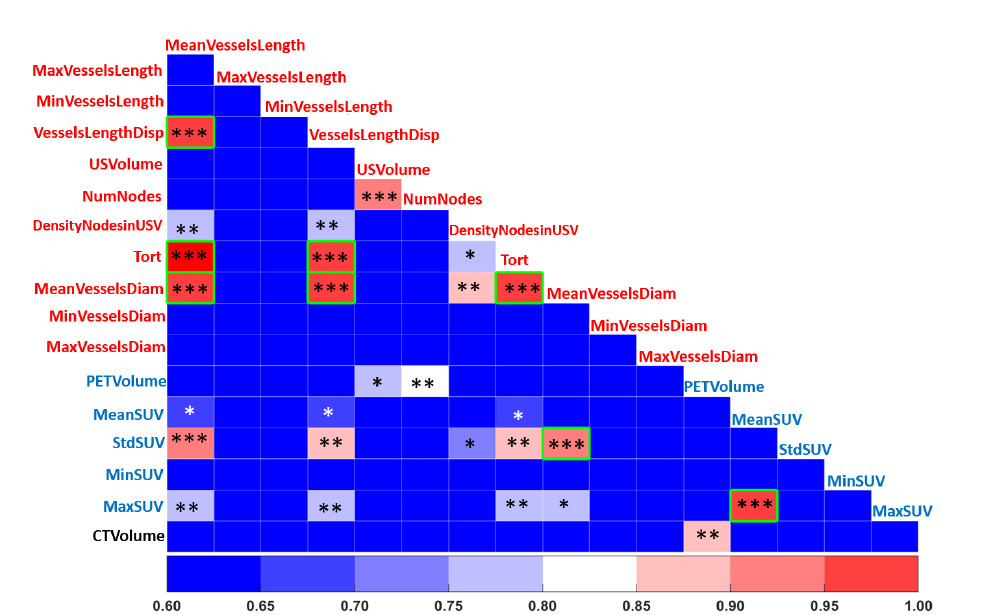
Figure 3. Heatmap summarizing significant Pearson coefficient values for each pair of metabolic (blue font), vascular (red font) and morphological features (black font) used to exclude redundant features (*, **, ***, refer to p -value level of significance).